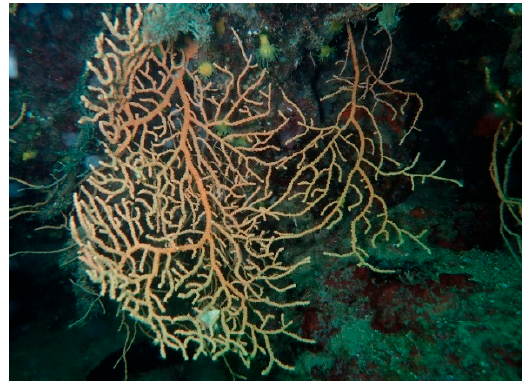
Figure 1. Eunicella cavolini from the Adriatic Sea (Rtina, Paška vrata, Croatia), geographical coordinates: Geographical longitude 44°19 ′ 14 ′ ’, geographical latitude 15°55 ′ 42 ′ ’.